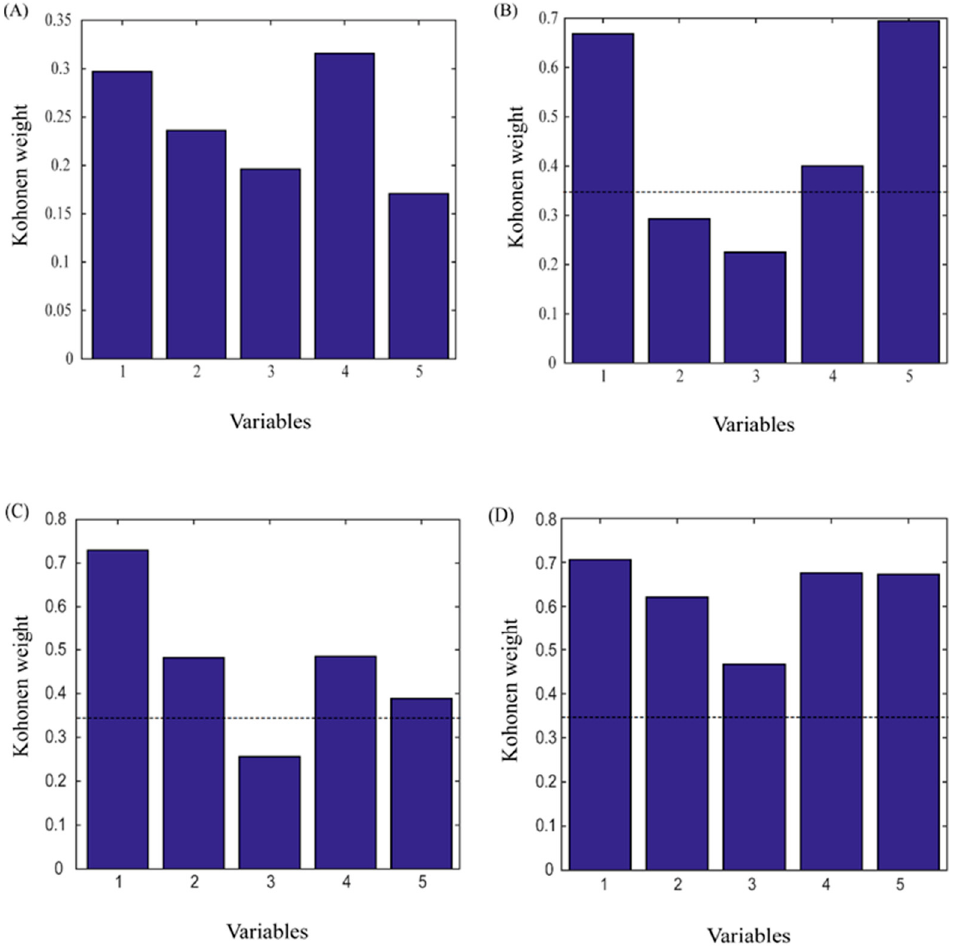
Figure 4. The Kohonen weights of the five flavonoids in four classes of associated-extraction efficiency from CP-ANN. ( A : OAE, B : traditional cyclodextrins, C : water-soluble cyclodextrin derivatives, D : ionic cyclodextrin derivatives 1: puerarin, 2: daidzein, 3: genistein, 4: genistin, 5: daidzin).